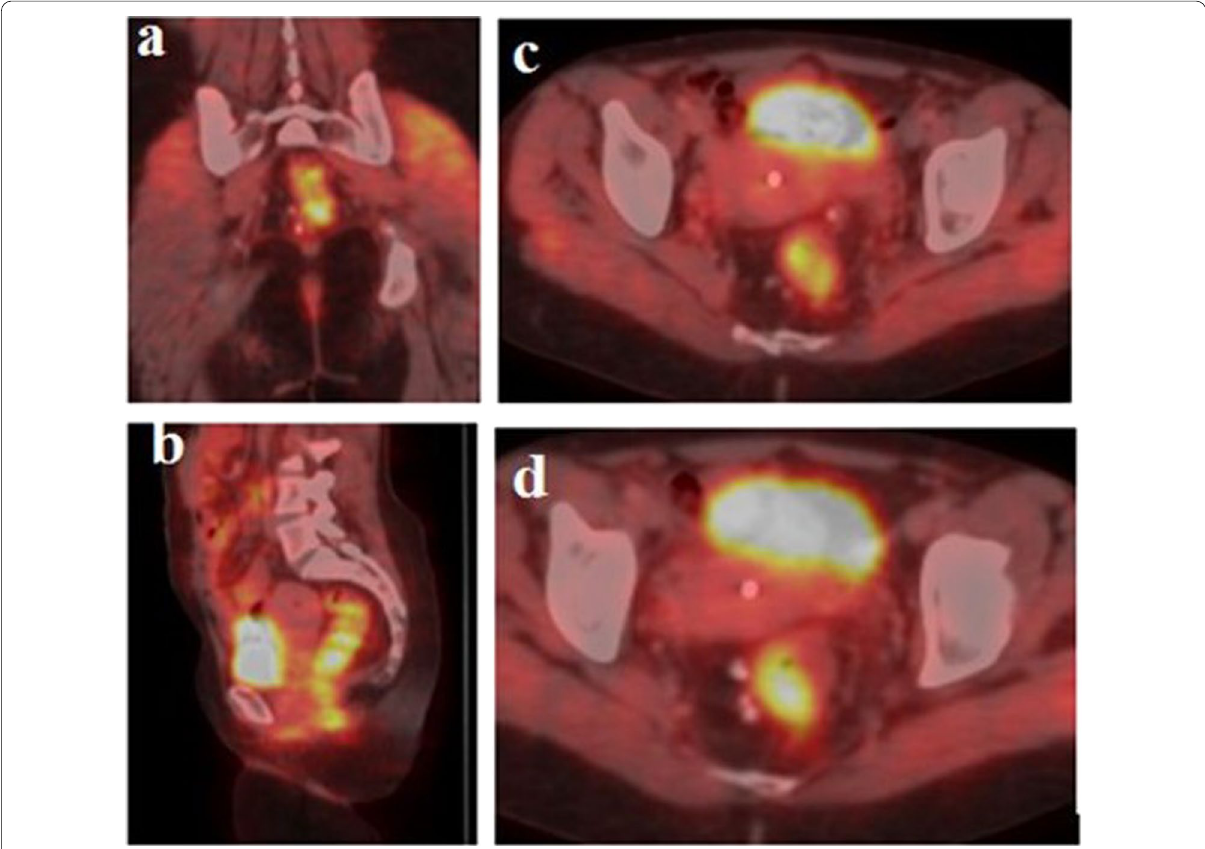
Fig. 5 a–d PET-CT study for the same patient in Fig. 4. Fused PET/CT images a, b coronal and sagittal, c, d axial images, revealed excellent agreement with MRI regarding the T category; showing metabolically active circumferential polypoidal mural thickening of the lower 1/2 of the rectum/ anorectal junction seen with max SUV ~ 5.38. However PETCT showed complete disagreement with MRI regarding the nodal assessment; as PET/CT revealed mostly calcified metabolically inactive (non FDG avid) mesorectal lymph nodes measuring up to 1.3 cm (regardless their shape, number and